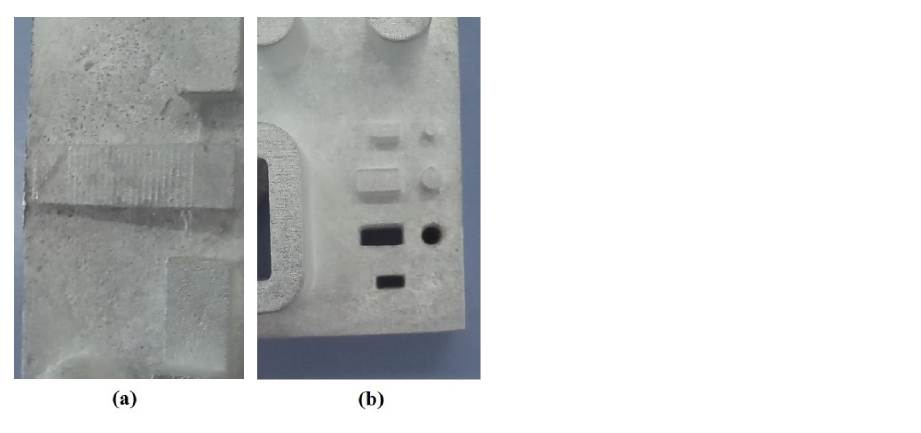
Figure 8. Close up view of casting part: ( a ) staircase effect on the cast ramp feature, ( b ) fine features.